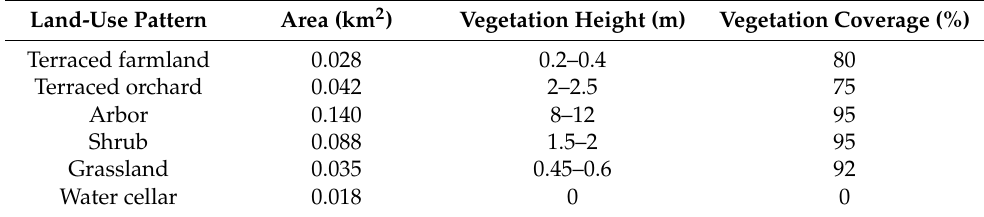
Table 1. The land-use patterns and vegetation coverage in the Kangjiagelao